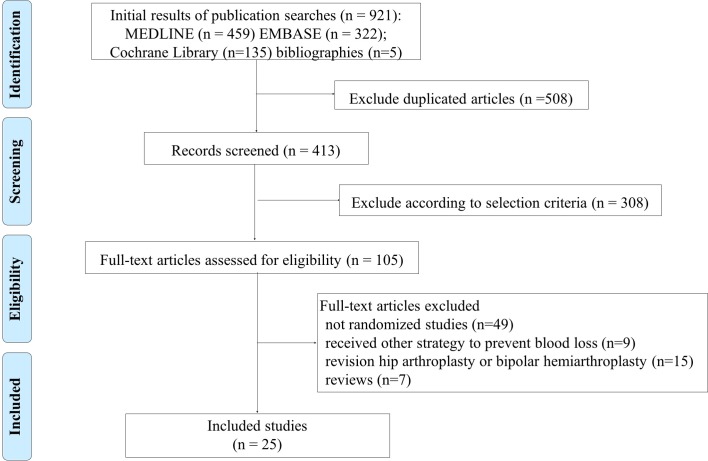
PRISMA Flow diagram details the process of relevant clinical study selection.